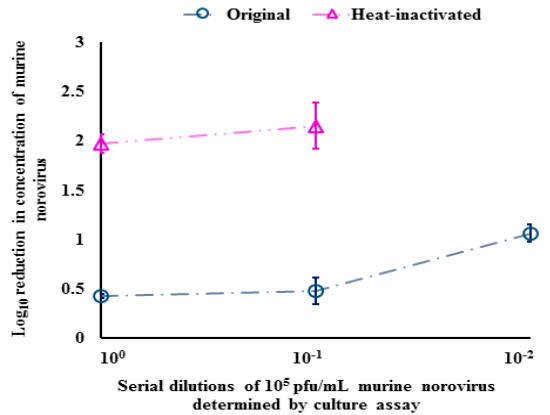
Figure 3. Log 10 reduction (mean and standard deviation) of original (non-heat-inactivated) and heat-inactivated murine norovirus after PEMAX TM treatment.